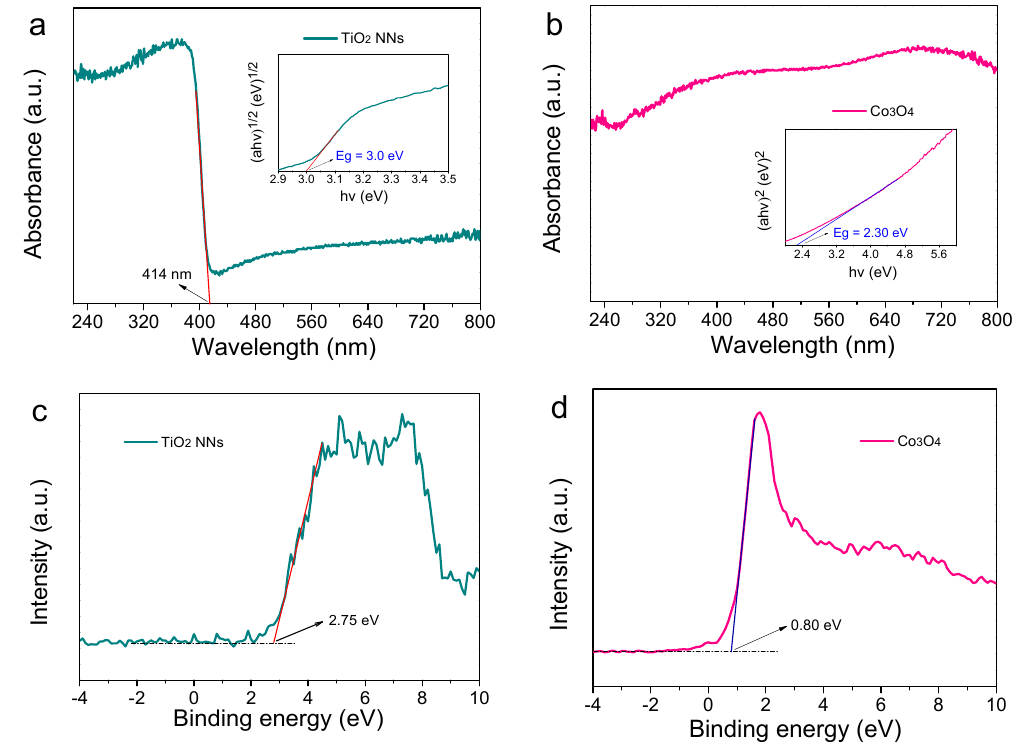
Figure 3. UV-Vis diffuse reflectance spectra of TiO 2 NNs photoanode with the inset of Taus’s plots of ( α h 𝜈 ) 1/2 versus h 𝜈 ( a ), Co 3 O 4 photocathode with the inset of Taus’s plots of ( α h 𝜈 ) 2 versus h 𝜈 ( b ). VB XPS spectra of TiO 2 NNs photoanode ( c ) and Co 3 O 4 photocathode ( d ). The transient photocurrent responses and EIS analysis were conducted in Na 2 SO 4 solution with or without LED light illumination to examine the separation and transfer ability of photogenerated charge carriers. As shown in Figure 4a, the photocurrent of the dual-photoelectrode PEC system (TiO 2 NNs-Co 3 O 4 ) was 0.060 mA cm − 2 , which was about 1.67 times and 20 times higher than those of the TiO 2 NNs-Pt (0.036 mA cm − 2 ) and Pt-Co 3 O 4 (0.004 mA cm − 2 ) PEC system, respectively. In addition, it could be seen from Figure 4b and Table S2 that the radius of the TiO 2 NNs-Co 3 O 4 system was smaller than that of the single-photoelectrode (e.g., TiO 2 NNs-Pt, Pt-Co 3 O 4 ) PEC system both in the dark and under LED illumination, indicating that the dual-photoelectrode PEC system had lower charge transfer resistance [26]. Therefore, compared with TiO 2 NNs-Pt and Pt-Co 3 O 4 , the dual-phot-electrode PEC system had excellent photogenerated charge carriers transfer performance, which was in agreement with recent research [25].